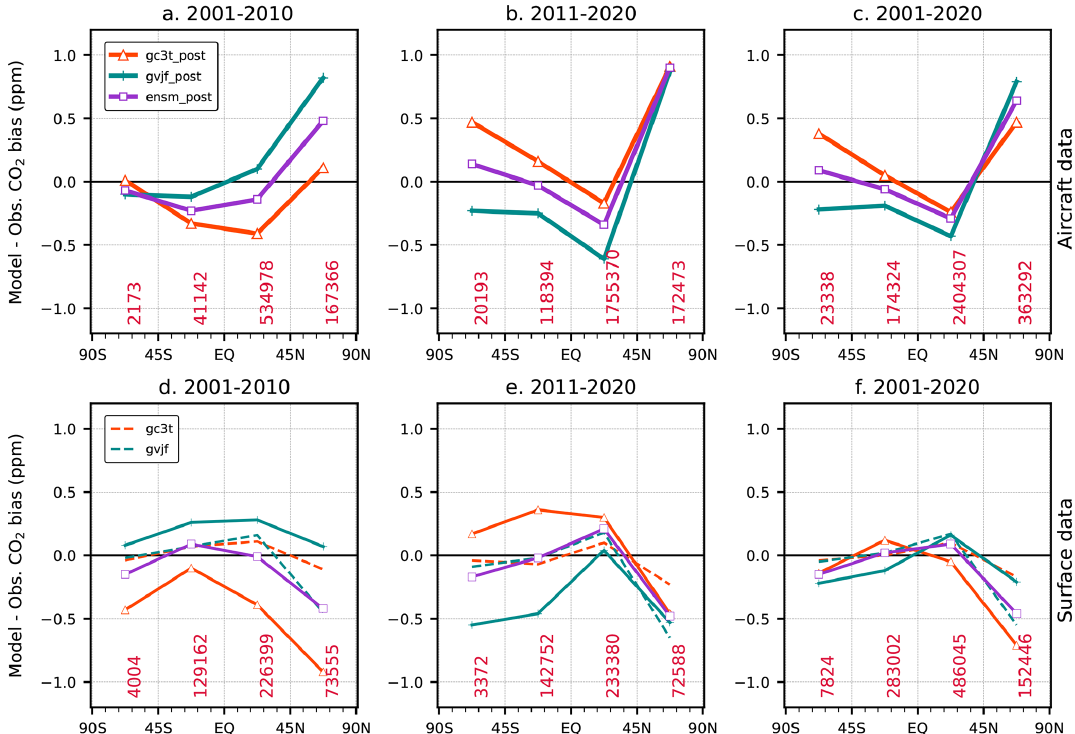
Figure 12. Evaluation of the atmospheric inversion products (solid lines; legend in panel a ). The mean of model–observation differences is shown for four latitude bands of 45 ◦ intervals in three time periods: (a, d) 2001–2010, (b, e) 2011–2020, and (c, f) 2001–2020. The simulations from three inversion cases are compared to independent CO 2 measurements made on board aircraft ( a–c : top row) over various parts of the world between 2 and 8km above sea level. Bottom row shows the model–observation differences for 50 surface sites that are used in the inversion (d–f) and mismatches between the a posteriori model (as obtained after optimizing regional sources by inversion) and CO 2 data (broken lines; legend in panel d ). Land and ocean data are used without distinction. The number in each panel shows the total number of data points used for computing bias for each latitude bin. The observation data are taken from obspack_co2_1_GLOBALVIEWplus_v6.1 (Schuldt et al.,